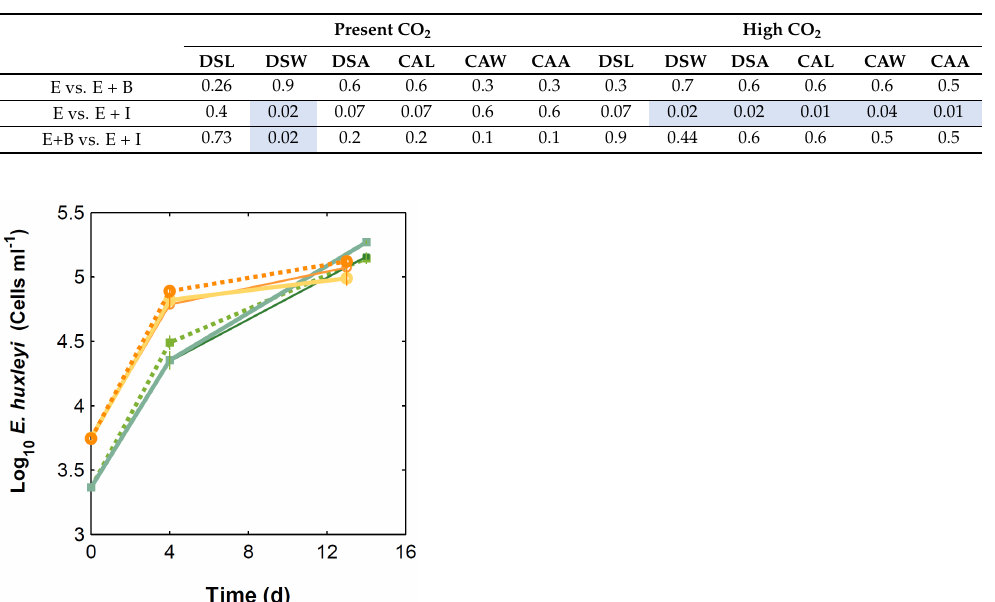
Table 1. Significance ( p value) of t -test comparing coccolith measures and communities analysed. E. huxleyi (E) and E. huxleyi co-cultured with Brachybacterium sp. (E + B) and with I. abyssalis (E + I). Coccolith measures are distal shield length (DSL) and width (DSW), central area length (CAL) and width (CAW) and calculated distal shield area (DSA) and central area area (CAA).